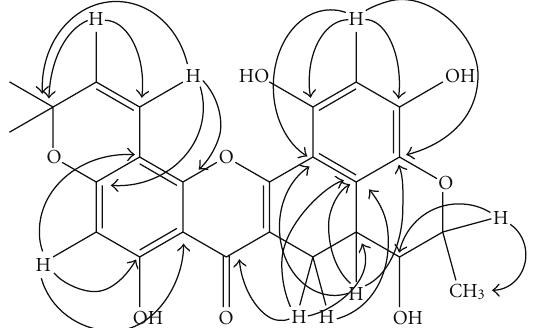
Figure 2: Selected HMBC of pyranocycloartobiloxanthone B ( 3 ).